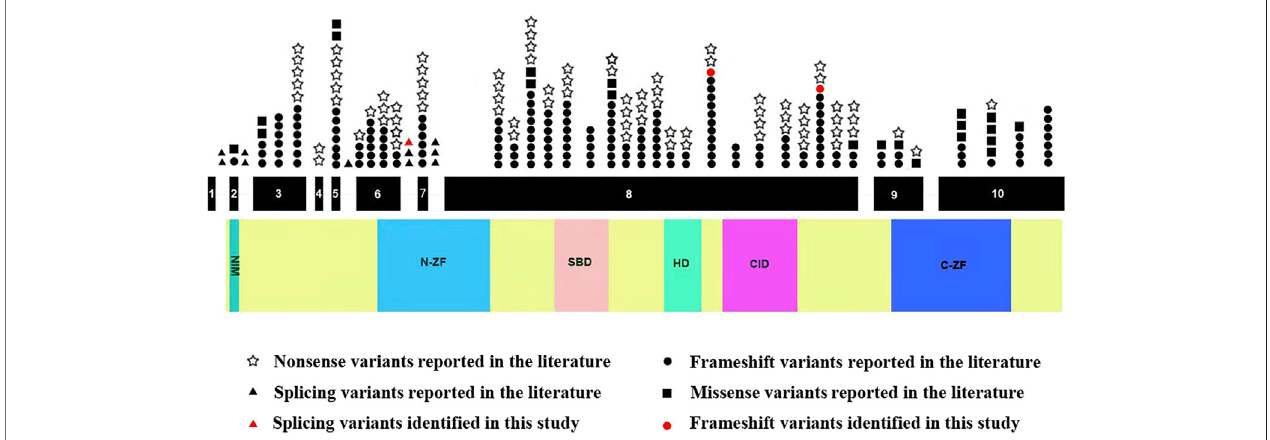
FIGURE 3 | Schematic representation of ZEB2 variants identi fi ed to date. The structure of ZEB2 contained 10 exons (black rectangles), introns (green horizontal line); lower side: the ZEB2 protein domains: NIM: NuRD-Interacting Motif (14 – 22); N-ZF: N-terminal Zinc Finger clusters (213 – 304); SBD: Smad-Binding Domain (437 – 487); HD: Homeodomain-like Domain (651 – 700); CID: CtBP-Interacting Domain (757 – 863); C-ZF: C-terminal Zinc Finger clusters (1,001 – 1,076).